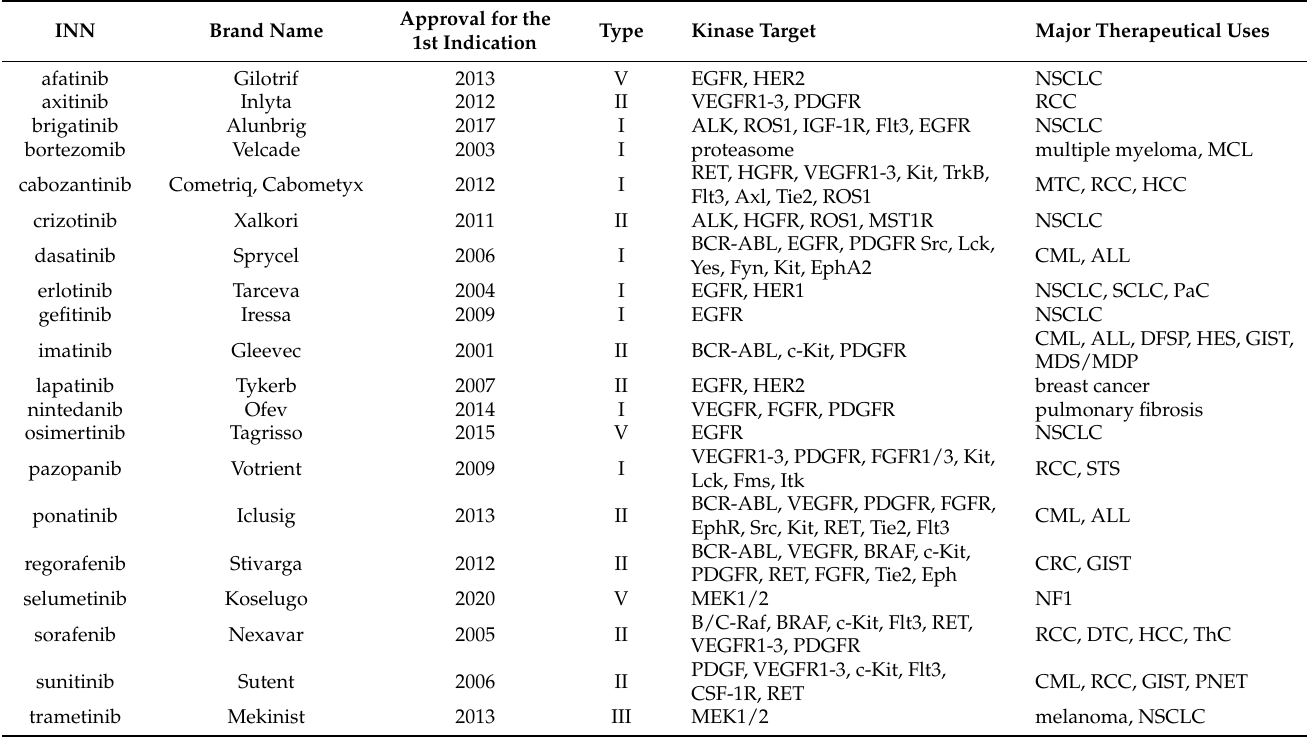
Table 1. A brief description [27,30,31,62,63] of selected TKIs arranged alphabetically by their interna- tional nonproprietary names (INN) formulated into lipid-based nanosystems.